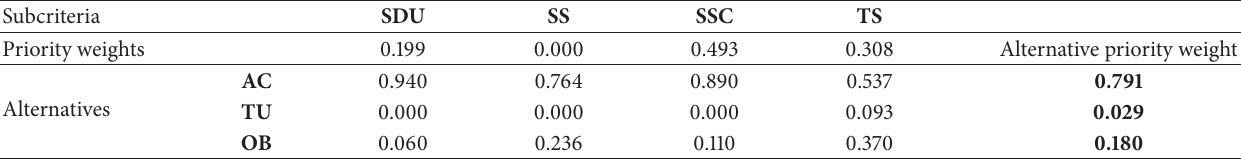
Table 6: Summary combination of priority weights: subcriteria of software technology and software performance.